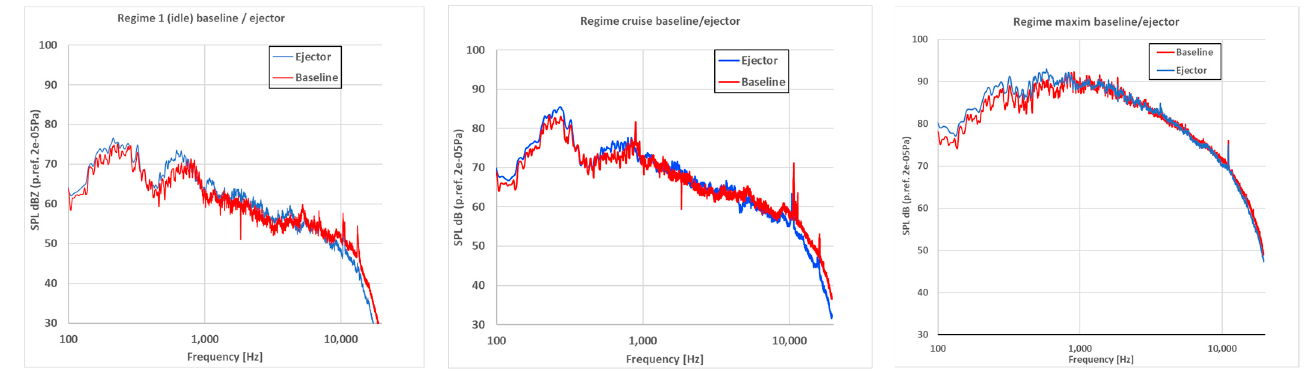
Table 2. Acoustic